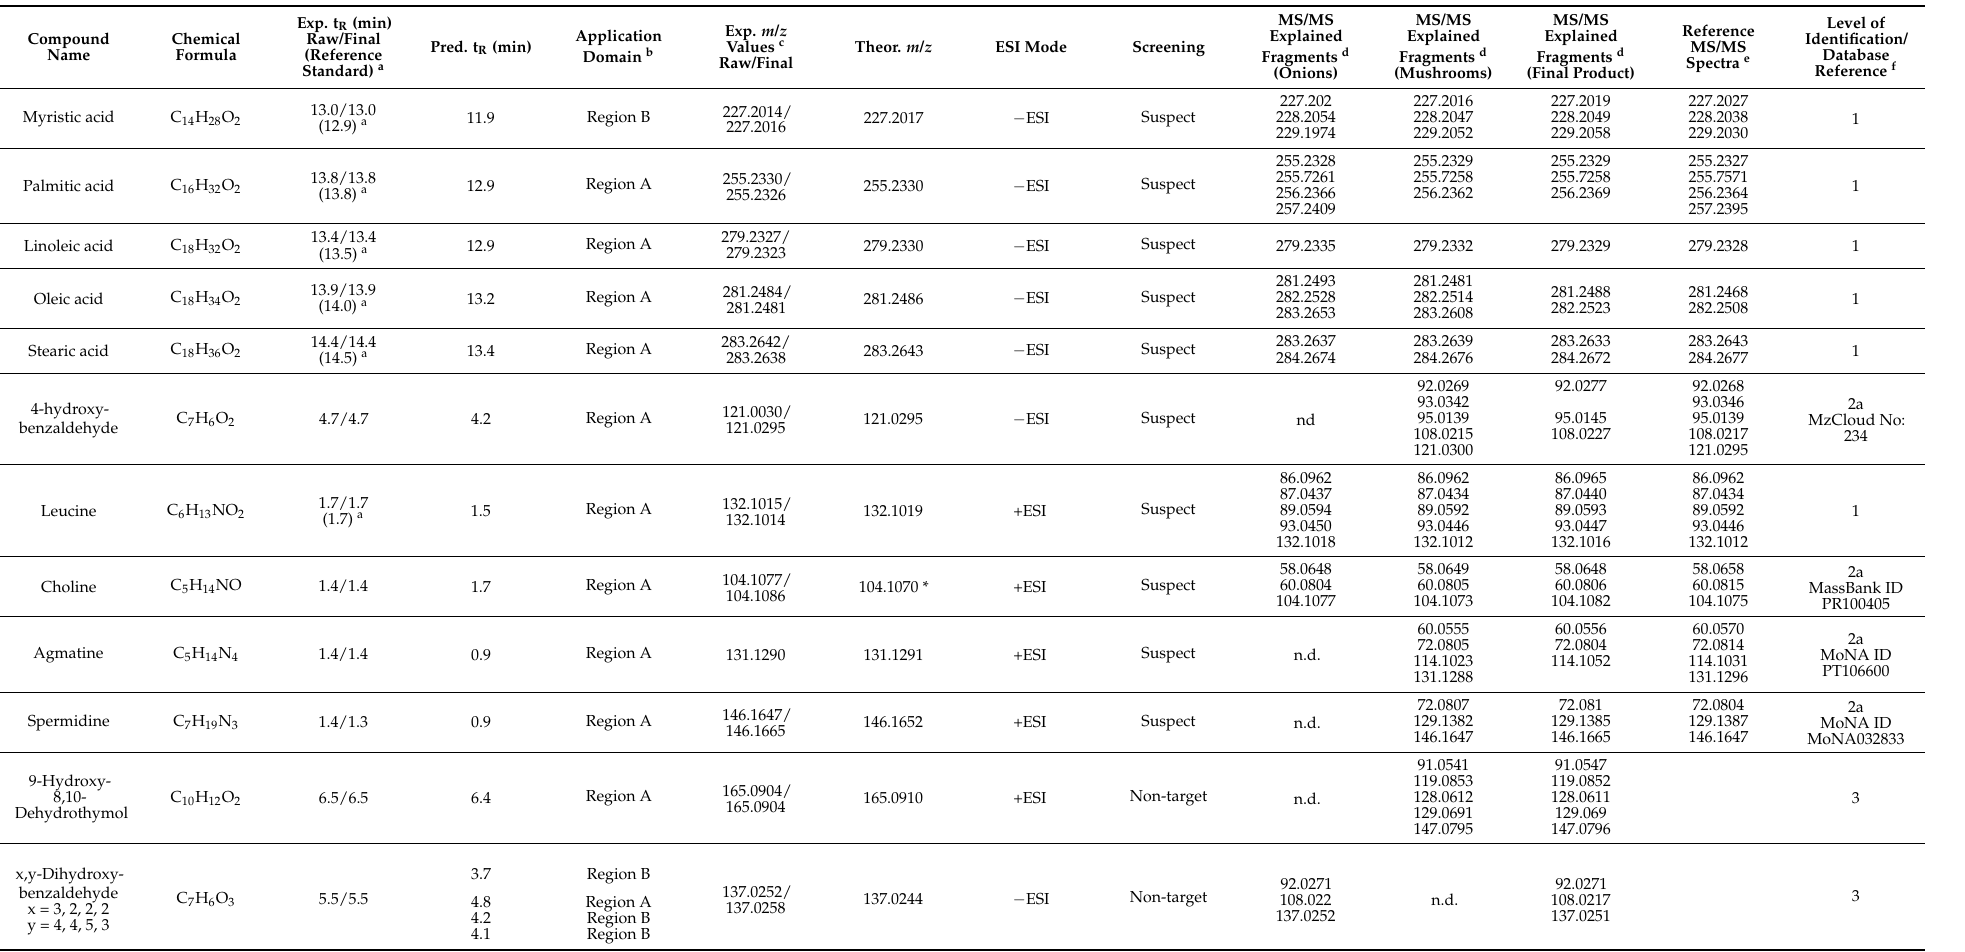
Table 2. Compounds identified through suspect and non-target screening in the raw materials and the mushroom-based final